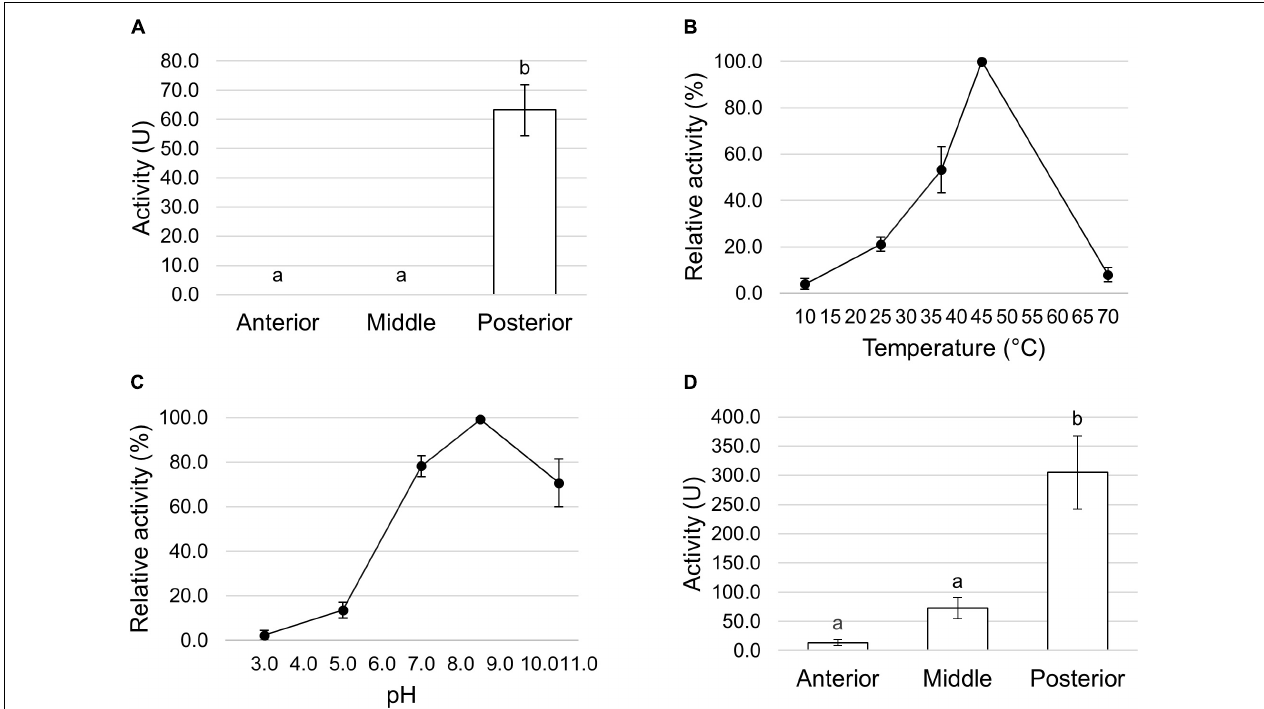
FIGURE 10 | Trypsin and chymotrypsin activity in the different midgut regions. (A) Trypsin activity in midgut juice extracted from anterior, middle, and posterior midgut. For each tract the enzymatic assay was performed at pH 8.5. The values are reported as mean ± SEM of 3 experiments. Different letters denote significant differences (ANOVA test followed by Tukey’s test. ANOVA p -value < 0.001, Tukey’s test p -values: Middle vs. Anterior p = 1.000, Posterior vs. Anterior p < 0.001, Posterior vs. Middle p < 0.001). (B) Dependence of trypsin activity on temperature in midgut juice from the posterior region of the midgut performed at pH 8.5. Relative activity values (%) are reported as mean ± SEM of at least 3 experiments and are expressed as percentage of the highest activity over the temperature range examined. (C) Dependence of trypsin activity on pH in midgut juice from the posterior region of the midgut performed at 45 ◦ C. Relative activity values (%) are reported as mean ± SEM of at least 3 experiments and are expressed as percentage of the highest activity over the pH range examined. (D) Chymotrypsin activity in midgut juice extracted from anterior, middle, and posterior midgut. For each tract the enzymatic assay was performed at pH 8.5. The values are reported as mean ± SEM of at least 3 experiments. Different letters denote significant differences (ANOVA test followed by Tukey’s test. ANOVA p -value < 0.05, Tukey’s test p -values: Middle vs. Anterior p = 0.845, Posterior vs. Anterior p < 0.05, Posterior vs. Middle p = 0.061).